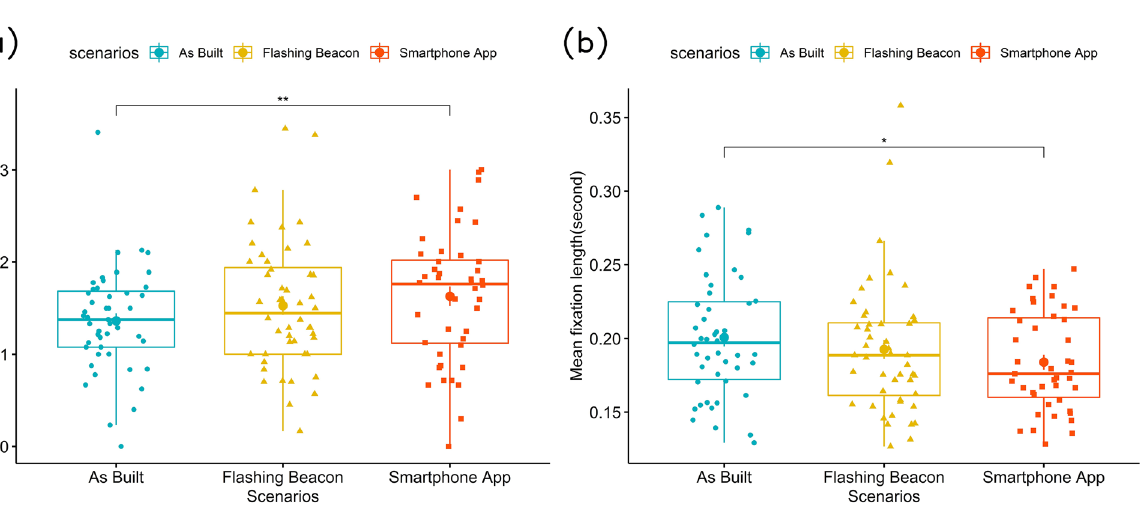
Figure 3. Fixation measurement during crossing of three scenarios, ( a ) fixation rate, ( b ) mean fixation duration.